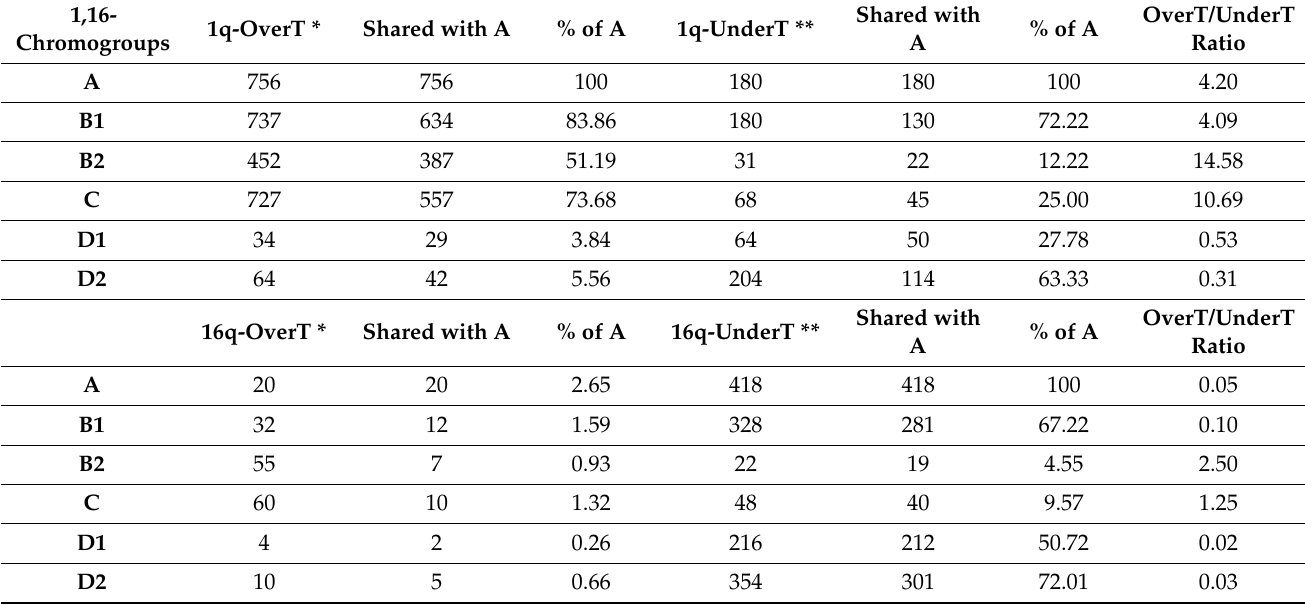
Table 2. Number of 1q- and 16q-OverT and 1q and 16q-UnderT in